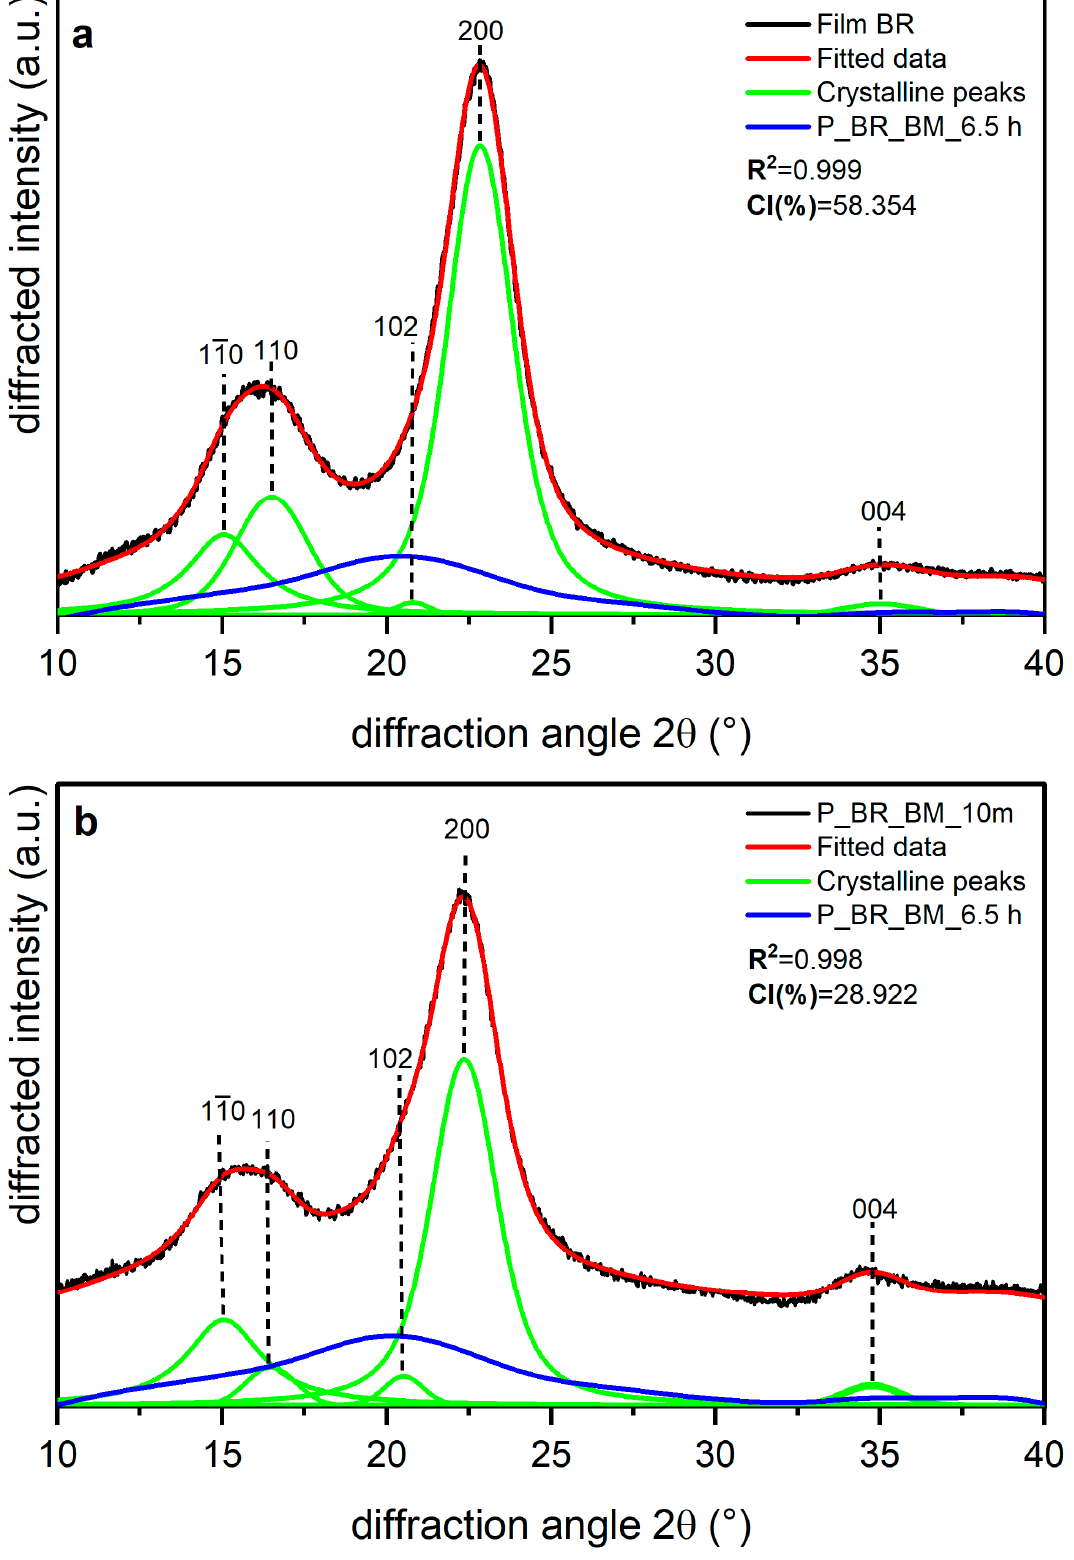
Figure 5. X-ray diffraction spectra recorded from banana rachis cellulose samples (BR): ( a ) unmilled (film BR), and ( b ) milled for 10 min (P_BR_BM_10 m) and 6.5 h (P_BR_BM_6.5 h). The indexation is that defined in [40].